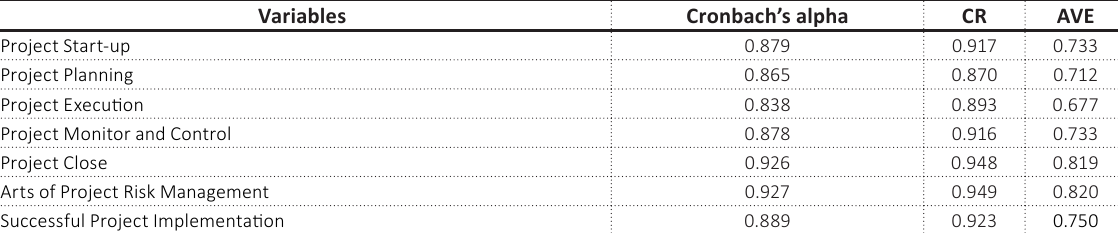
Table 3. Reliability and validity